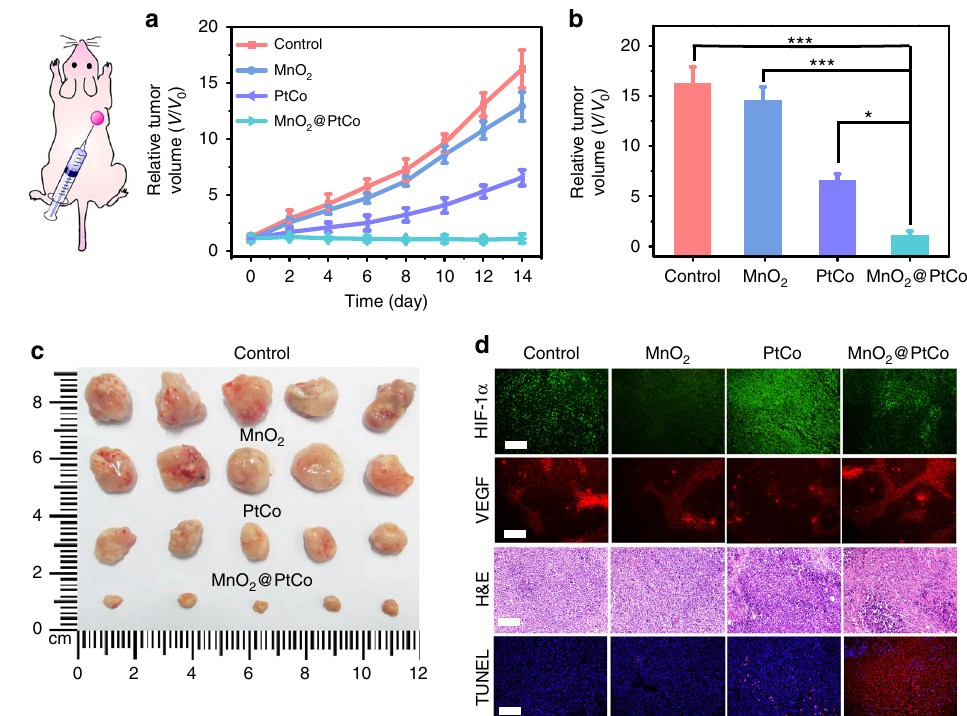
Fig. 8 In vivo therapeutic performance of MnO 2 @PtCo nano fl owers by intratumoral injection. a Time-dependent tumor volume changes after different treatments. b Comparison of inhibition effect of MnO 2 , PtCo, and MnO 2 @PtCo on tumor growth after 14 days post injection. Asterisks indicate signi fi cant differences ( * P < 0.01, ** P < 0.005, *** P < 0.001), analyzed by unpaired Student ’ s two-sided t test. c Photos of the tumors extracted from mice in different groups at the end of treatments (day 14). d Representative immuno fl uorescence images of tumor slices after hypoxia staining. The hypoxia positive areas and blood vessels were stained by HIF-1 α and VEGF, respectively. H&E staining and TUNEL staining of tumor tissues at the 14th day. Nuclei were stained blue (DAPI staining), and apoptotic cells were stained red (TUNEL staining). Scale bars are 100 μ m. Data were presented as mean ± s.d. ( n =